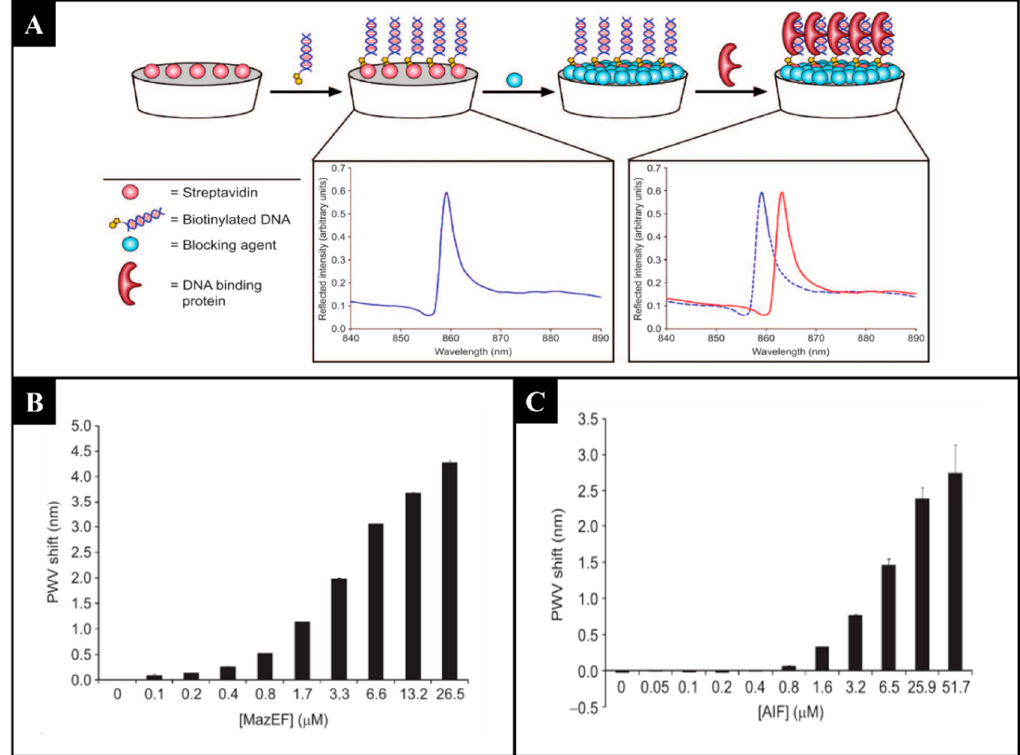
Figure 6. ( A ) Example of an HTS based on photonic crystals for the study of protein–DNA interactions, where the peak wavelength value (PWV) is measured, in particular for different concentrations of ( B ) toxin–antitoxin chromosomal module of Escherichia coli (MazEF) and of ( C ) apoptosis-inducing factor (AIF). (Reproduced with permission [152], Copyright 2008, American Society of Chemistry.)